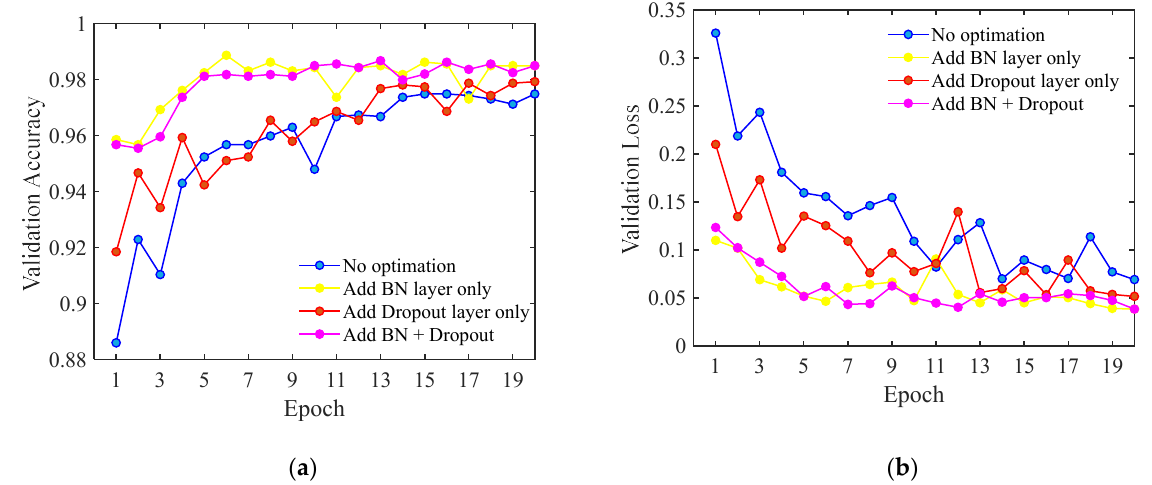
Figure 6. The validation ( a ) accuracies and ( b ) losses of the cases with different overfitting control strategies.